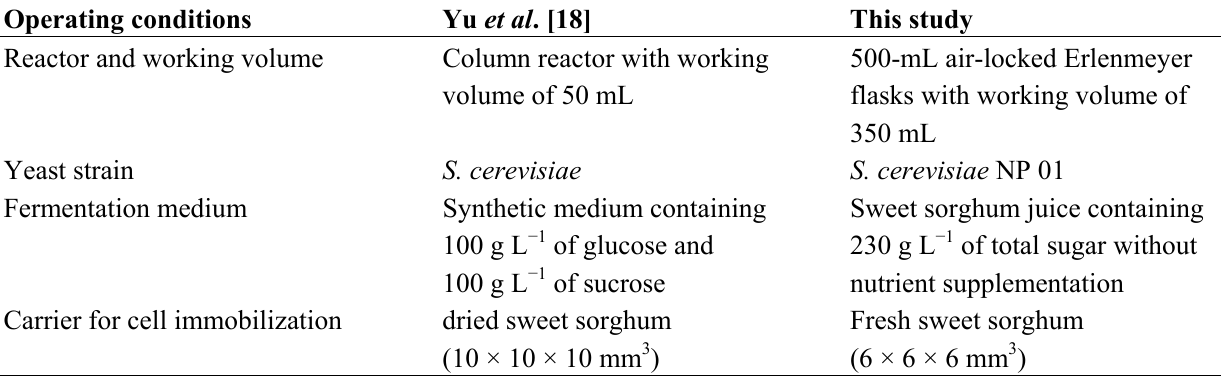
Table 4. Comparison of repeated-batch ethanol fermentation by yeast cells immobilized on sweet sorghum